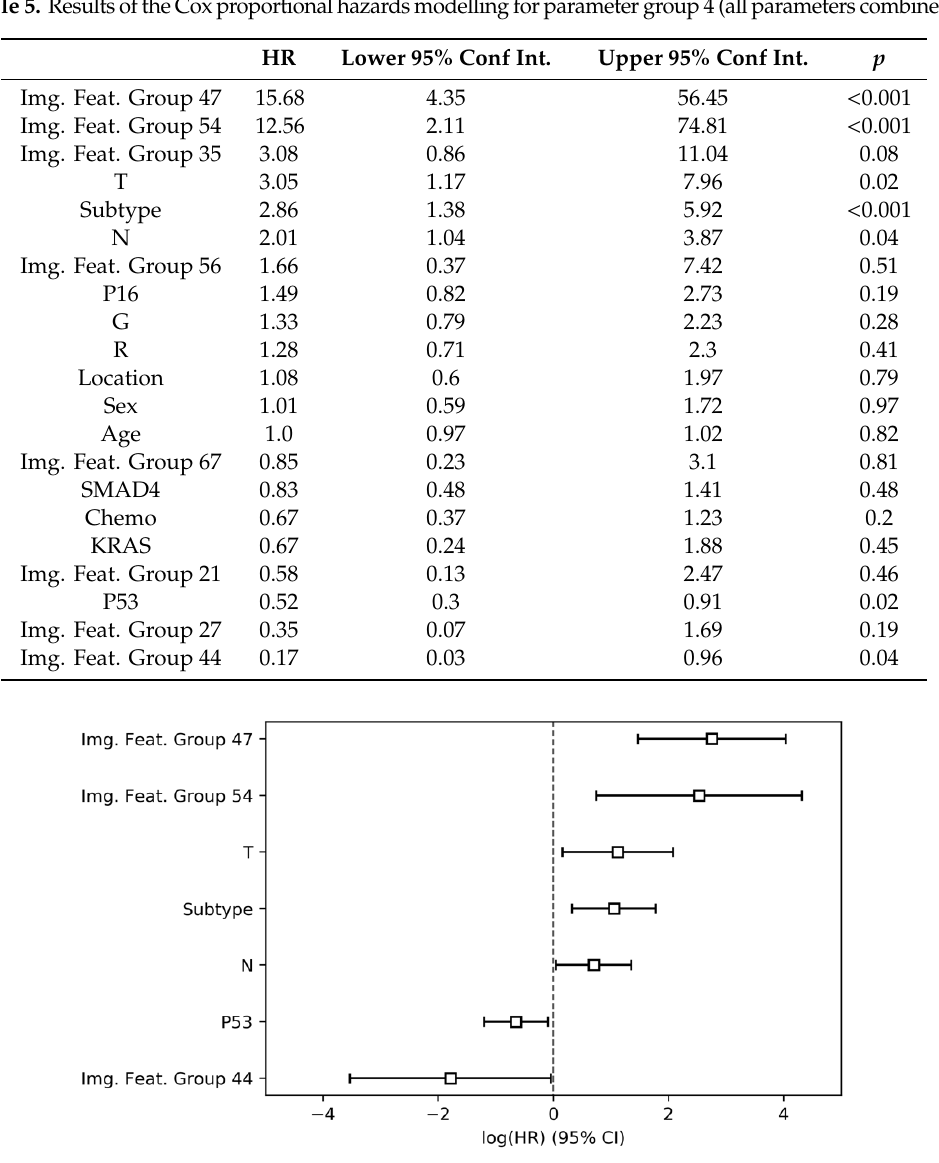
Figure 4. Figure 4. Hazard ratios and 95% confidence intervals of parameter group 4 (all parameter groups combined).